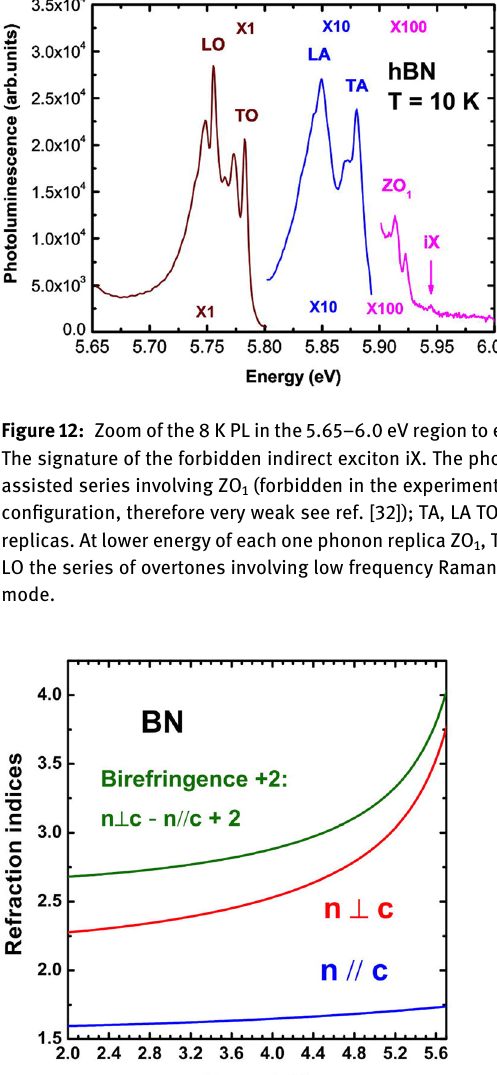
Figure13: Plotofthein-plane(red)andout-of-plane(blue)refractive index as a function of energy showing the giant natural anisotropy (green) of hBN. The plot of giant natural anisotropy of hBN has been shifted by 2. The parameters used for the plot were taken from reference